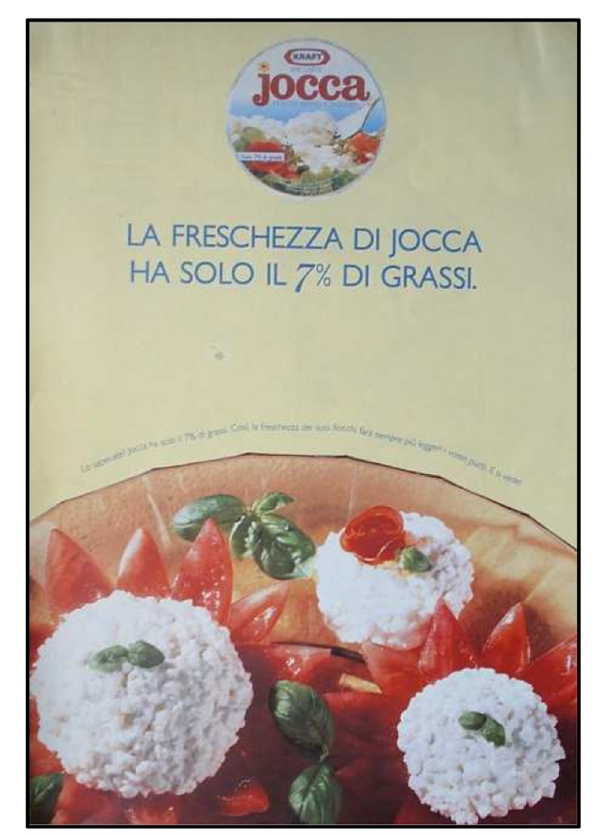
FIGURE 7 | The freshness of Jocca has only 7%